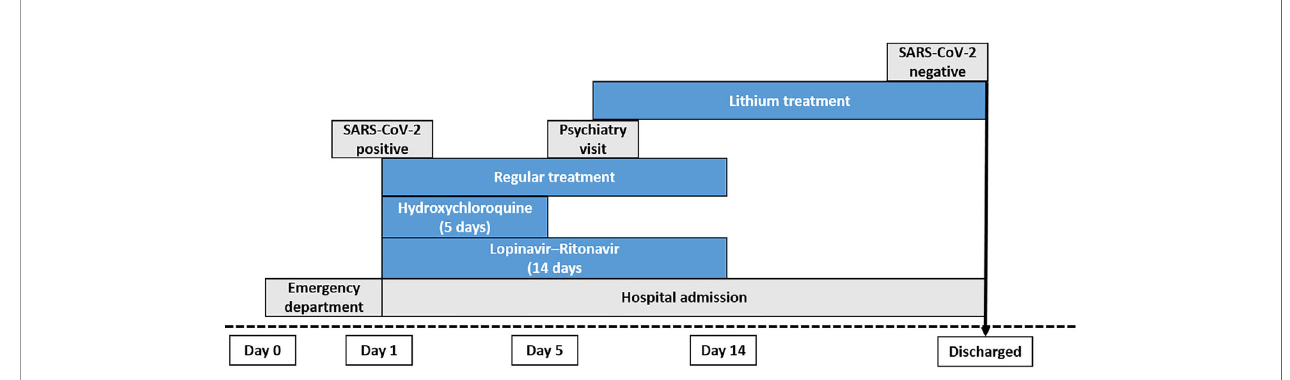
FIGURE 1 | Diagram of the work fl ow and treatment followed for each patient treated with lithium carbonate. All of the lithium-treated and control patients, with the exception of patient 4, were treated with regular COVID-19 therapy (hydroxychloroquine for 5 days and lopinavir-ritonavir for 14